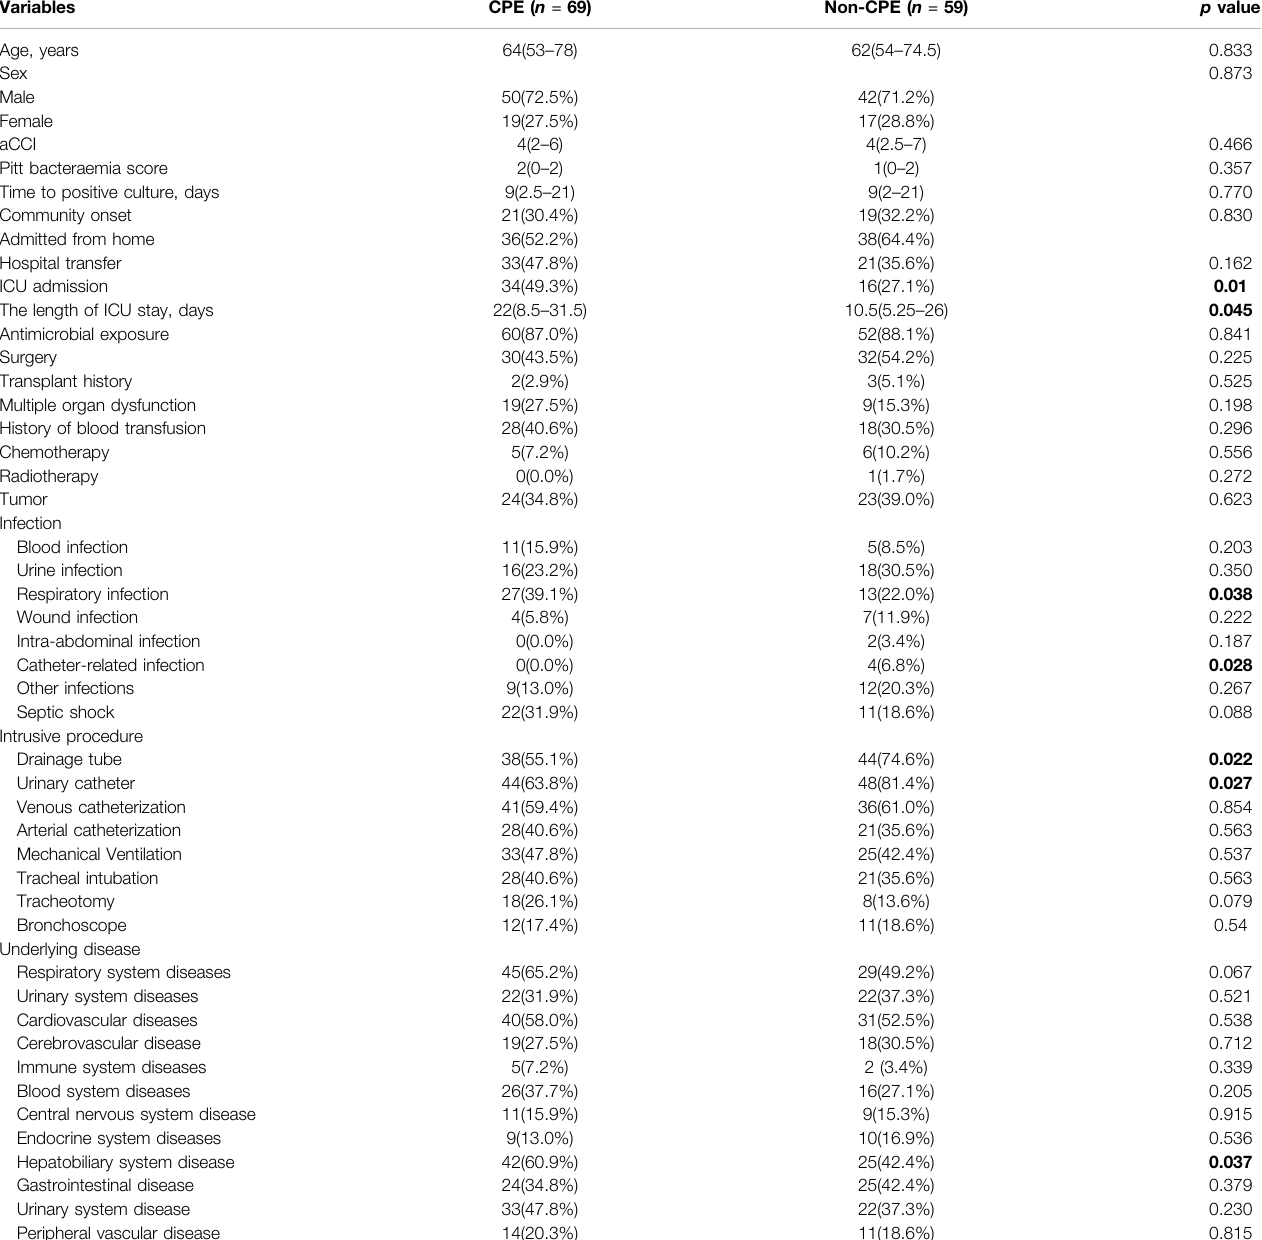
TABLE 3 | Baseline characteristics of patients with CRE infection.